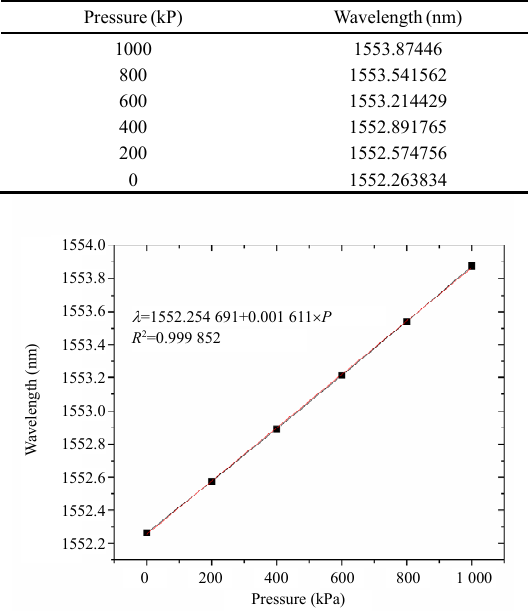
Fig. 6 Linear calibration curve of the calibration data for the pressure